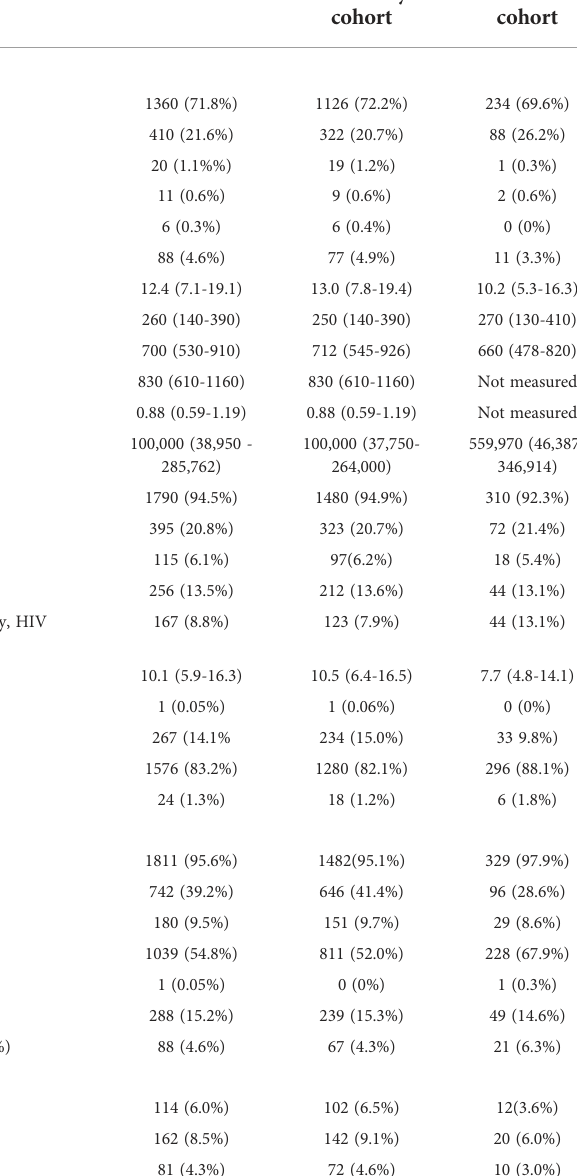
TABLE 2 Baseline HIV-related characteristics of study